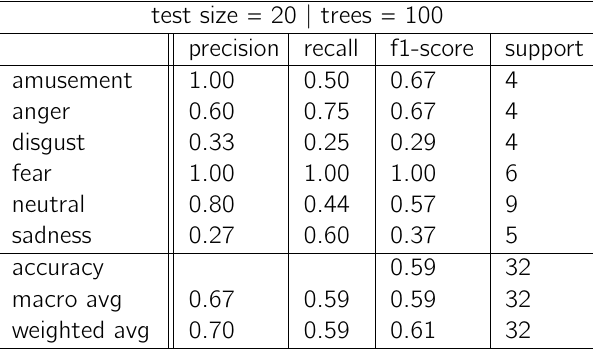
Figure 7: Confusion matrix for the results produced by the model using the three category data set with SMOTE data